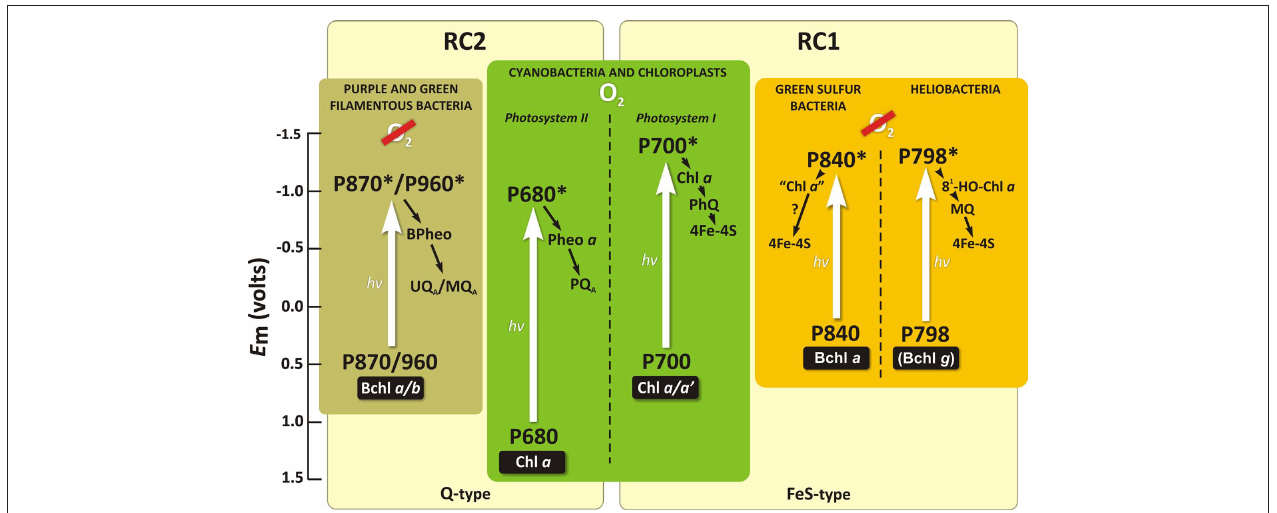
FIgurE 12 | A simplified scheme representing the rCs in various groups of photosynthetic organisms. The initial electron donor (P), as well as the primary and secondary electron acceptors are shown for each RC. Straight white arrows are for excitation of RC molecules that leads to an electron jump from the ground state into the higher excited singlet state, in response to the absorption of light quanta ( hv ). The number behind P indicates the long wavelength